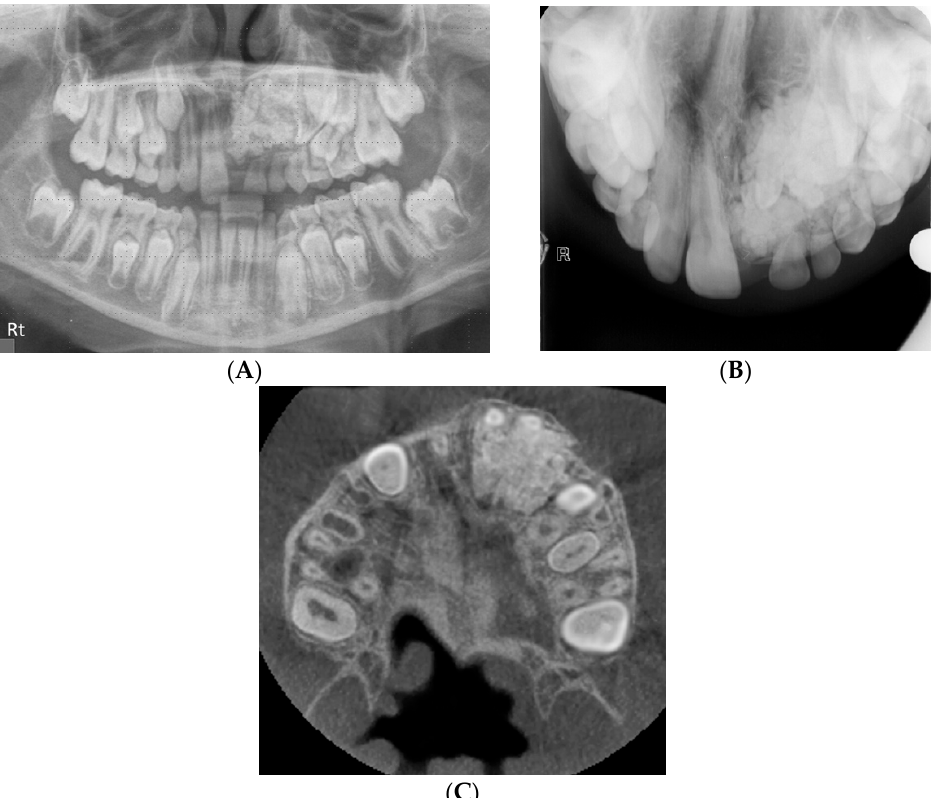
Figure 2. ( A ) Panoramic radiograph showing a mixed complex-compound odontome in the left anterior maxilla. ( B ) Upper standard occlusal view of the mixed complex-compound odontome. ( C ) CBCT axial view demonstrating the full extent of the odontome and its relationship to the teeth.